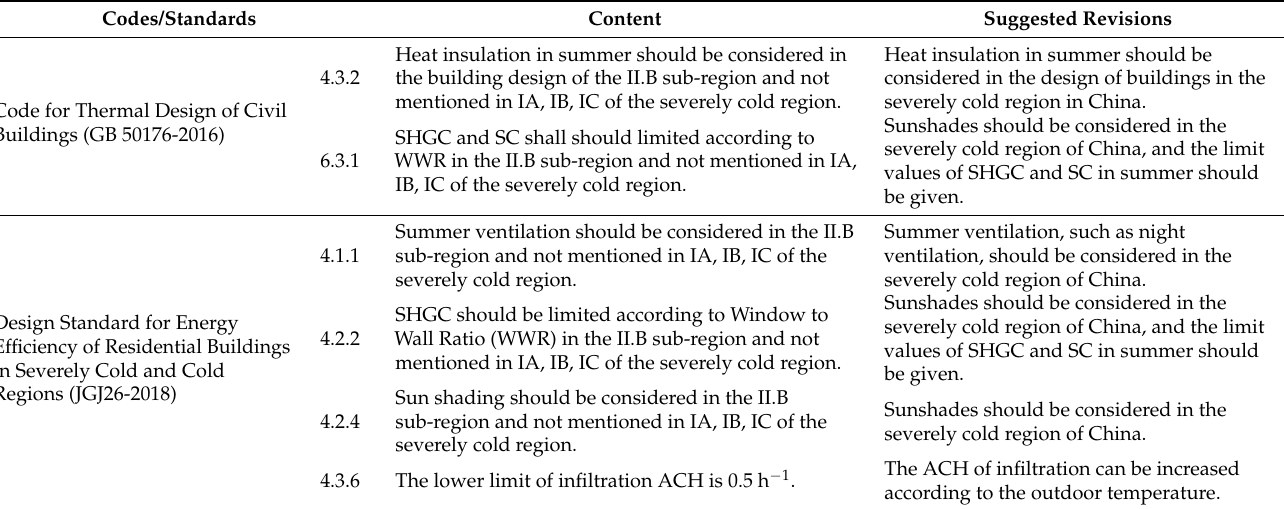
Table 8. Suggestions for revising China’s summer thermal protection requirements and standards.